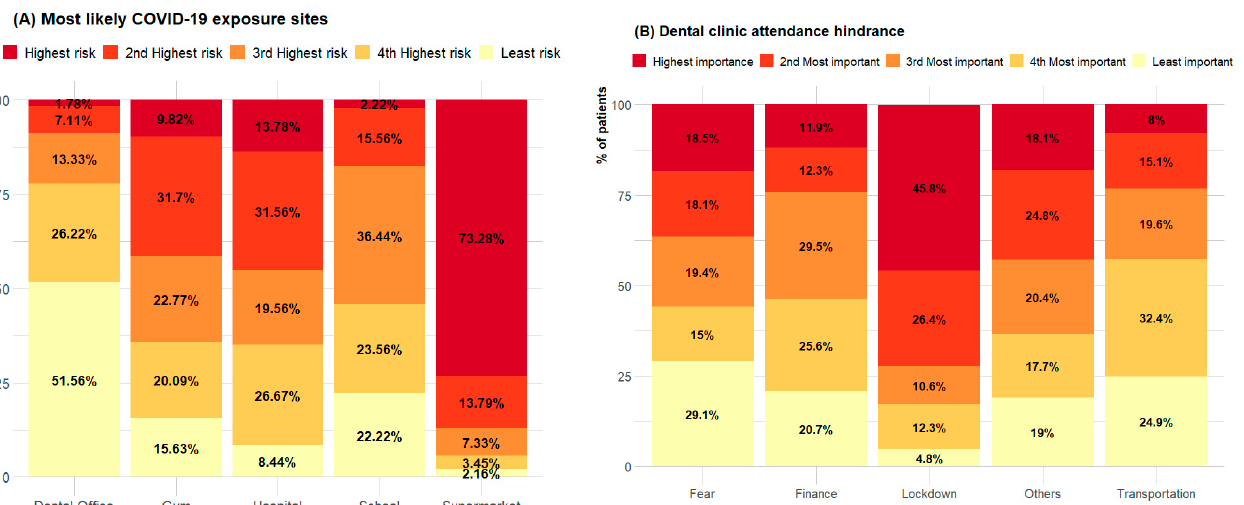
Table 4. Responses to questionnaire items on attitudes regarding dental visits during the COVID ‐ 19 pandemic (responses are based on a 5 ‐ point Likert scale).